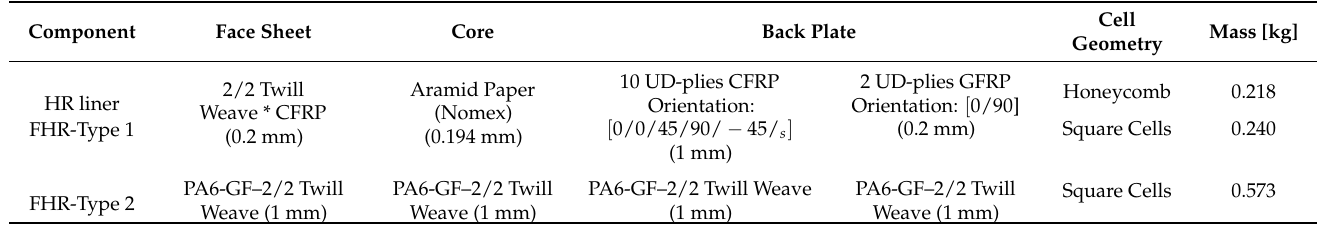
Table 3. Structure component, corresponding materials and thickness of the acoustic liner configura- tion.